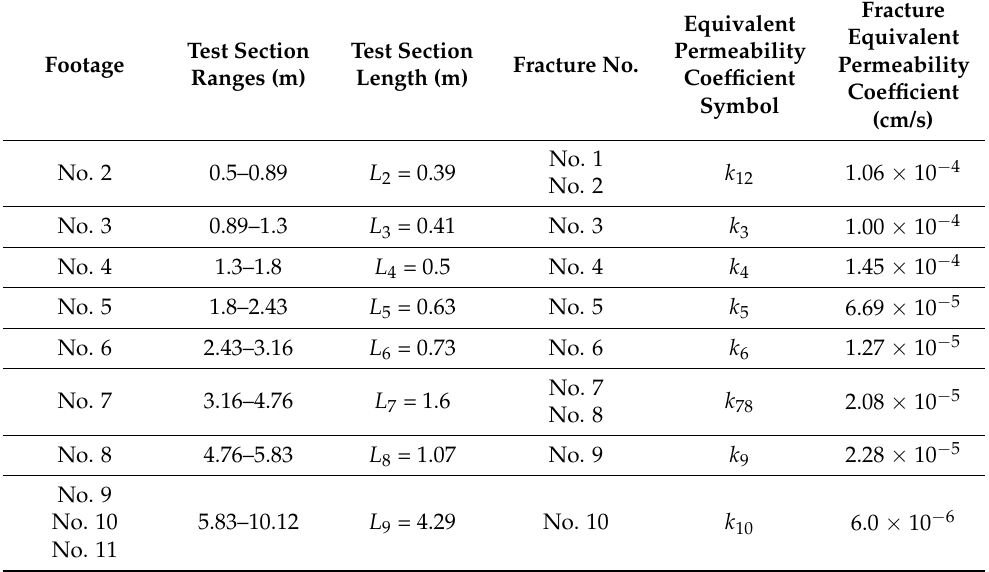
Table 8. Symbol of fracture information.